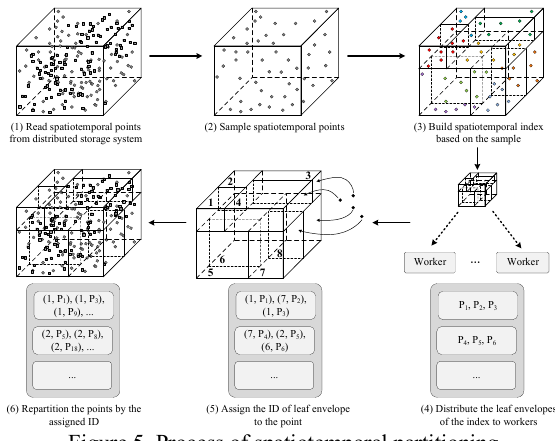
Figure 5. Process of spatiotemporal